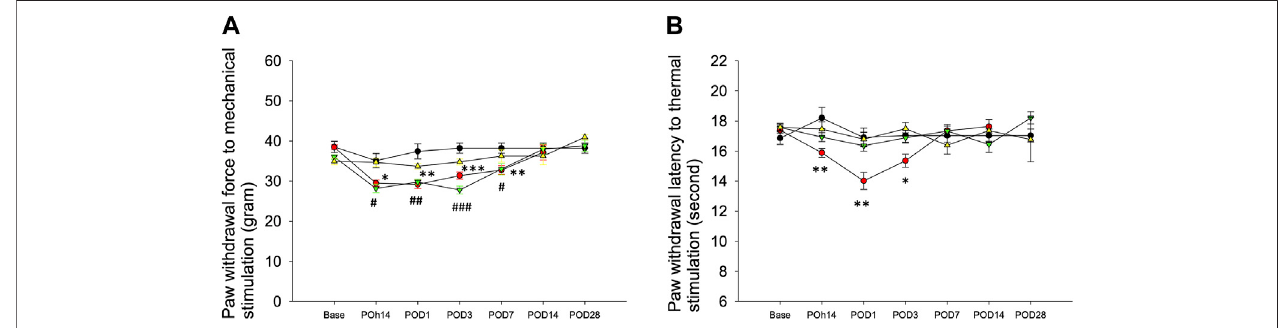
FIGURE 2 | Behavioral responses to mechanical and thermal stimuli. The hind paw withdrawal responses to (A) mechanical and (B) thermal stimuli after Intrafascicular saline injection (InF-S, red circle), intrafascicular ropivacaine injection (InF-R, green invert triangle) into sciatic nerve or needle pierce sciatic nerve only (InF- P,yellowtriangle)weremeasured.shamgroup(black circle),removalofleftsixthlumbarspinetransverseprocessonlywasincluded.Therearenosigni fi cantdifferences inwithdrawallatenciesbetweenhindpawsintheshamgroupandneedlepiercegroup.Ascomparedwithshamgroup,intrafascicularsalinesigni fi cantlydecreased withdrawal latencies to mechanical and thermal. Intrafascicular ropivacaine induced mechanical hypersensitivity only. POD: postoperative day, n = 30/group, 4 – 5/each time point. Compare InF-S and sham groups, *** p < 0.001; ** p < 0.01; * p < 0.05. Compare InF-R and sham groups, ### p < 0.001; ## p < 0.01; # p < 0.05. Group differences were compared by Mann – Whitney U -test. Error bars represent SE.